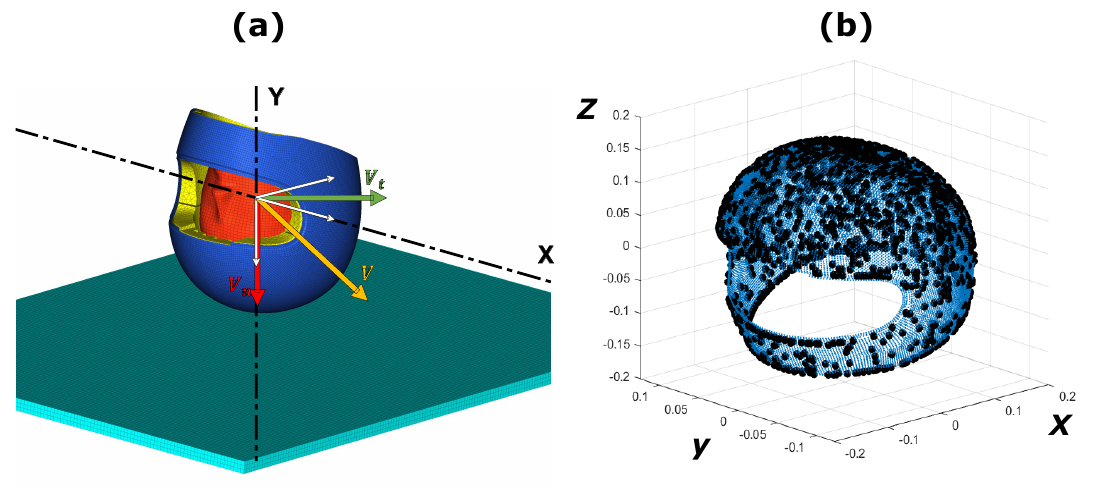
Figure 1. ( a ) Start of the first head-impact scenario; ( b ) scatter plot of the shell mesh nodes (blue points) and the impact points (black points) for the entire training